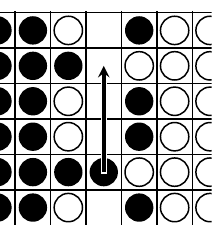
Figure 28. BLACK comes in.